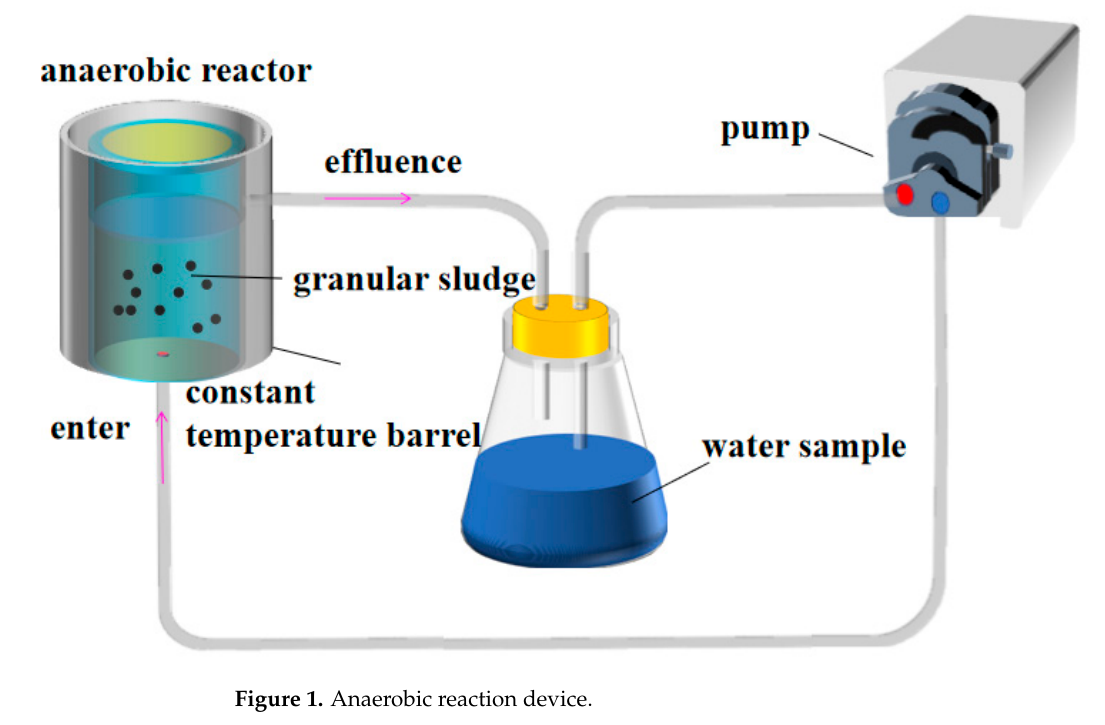
Figure 1. Anaerobic reaction device.